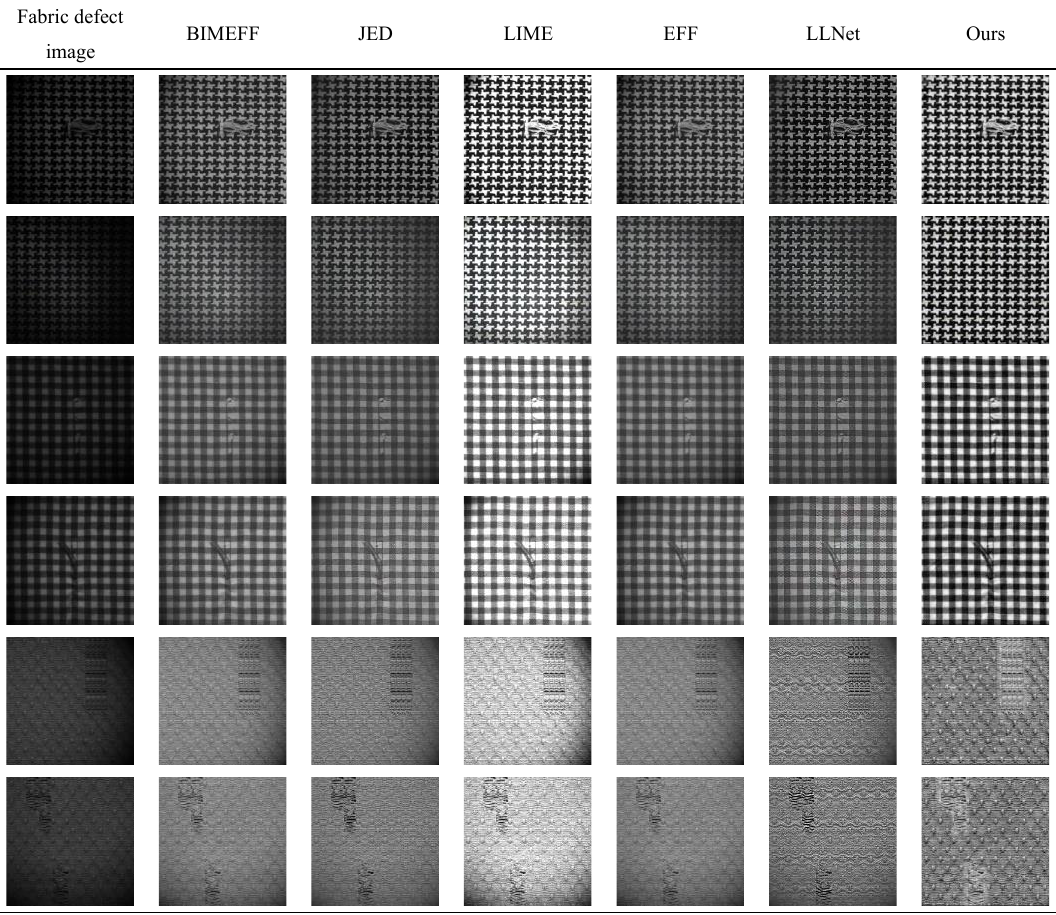
Figure 7. Comparison of different illumination correction methods.